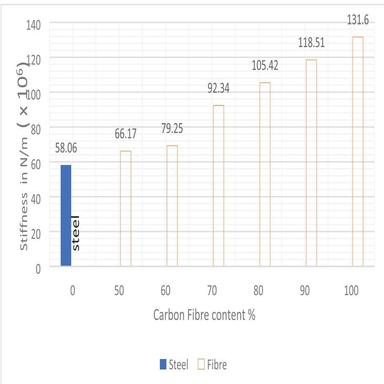
Stiffness of steel and composite drive shaft.